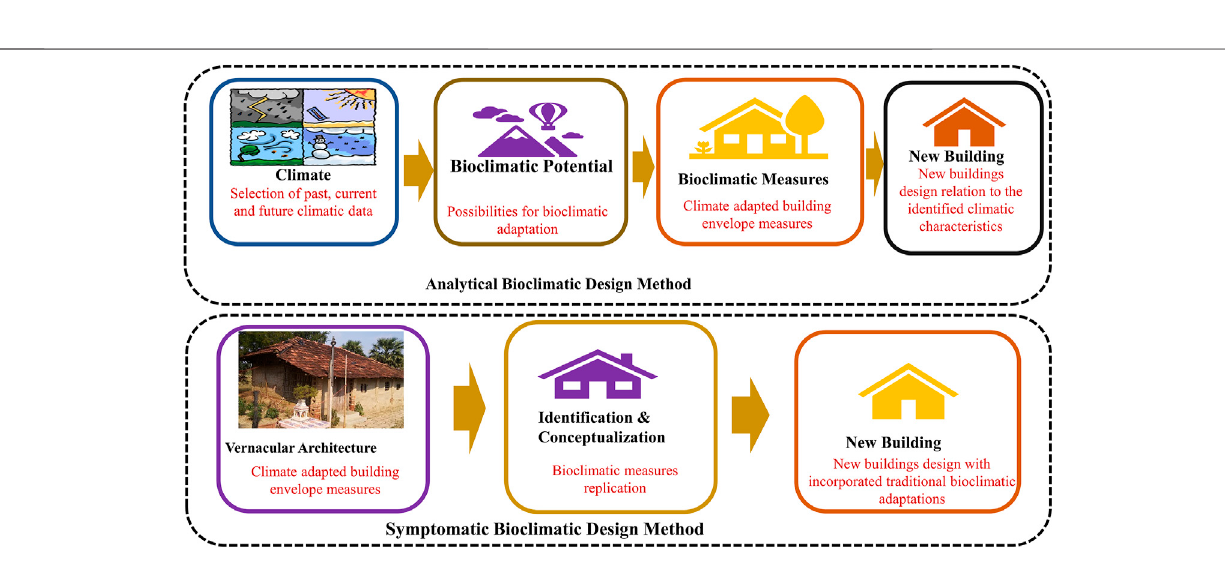
Frontiers in Built Environment |